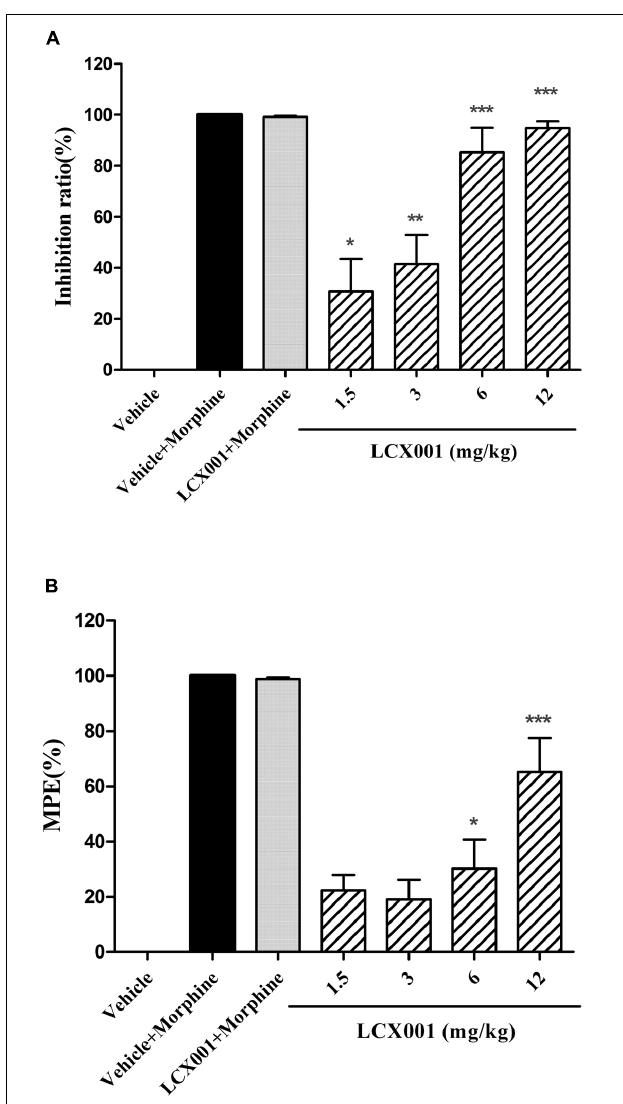
FIGURE 2 | Anti-nociceptive effect of LCX001. Morphine (2.5 or 10 mg/kg, s.c.) was used as positive control drug. (A) Effect of LCX001 in the writhing test. 10 min before 0.6% acetic acid treatment, LCX001 administration (1.5, 3, 6, and 12 mg/kg, i.v.) significantly inhibited acetic acid-induced writhing compared to vehicle (20% HPCD, i.v.); mean ± SEM, each group contained 10 male KM mice. (B) Effect of LCX001 in the hot-plate test. LCX001 at 6 and 12 mg/kg (i.v.) markedly increased %MPE after the hot-plate stimulation as compared with the vehicle control group. ∗ Significant difference by one-way